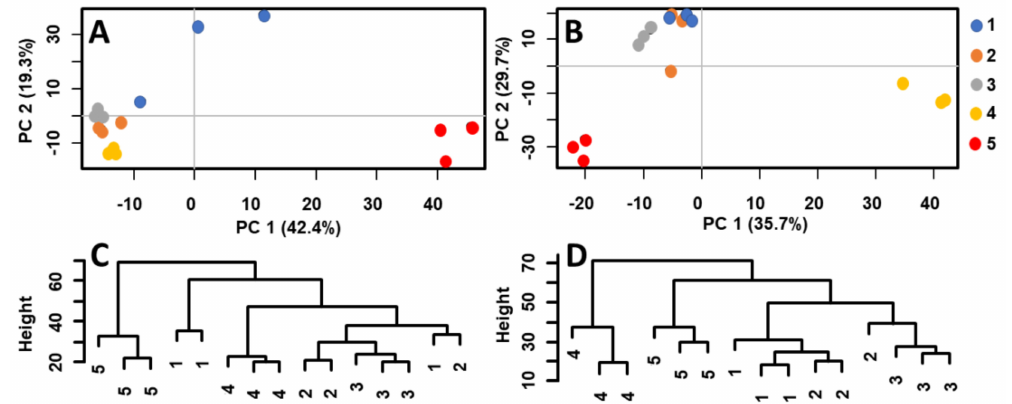
Figure 1. Score plots and dendrograms of MALDI-MS data measured in acetone extracts of five soil layers from ceramic vessels no. 4 ( A,C ) and no. 5 ( B,D ),